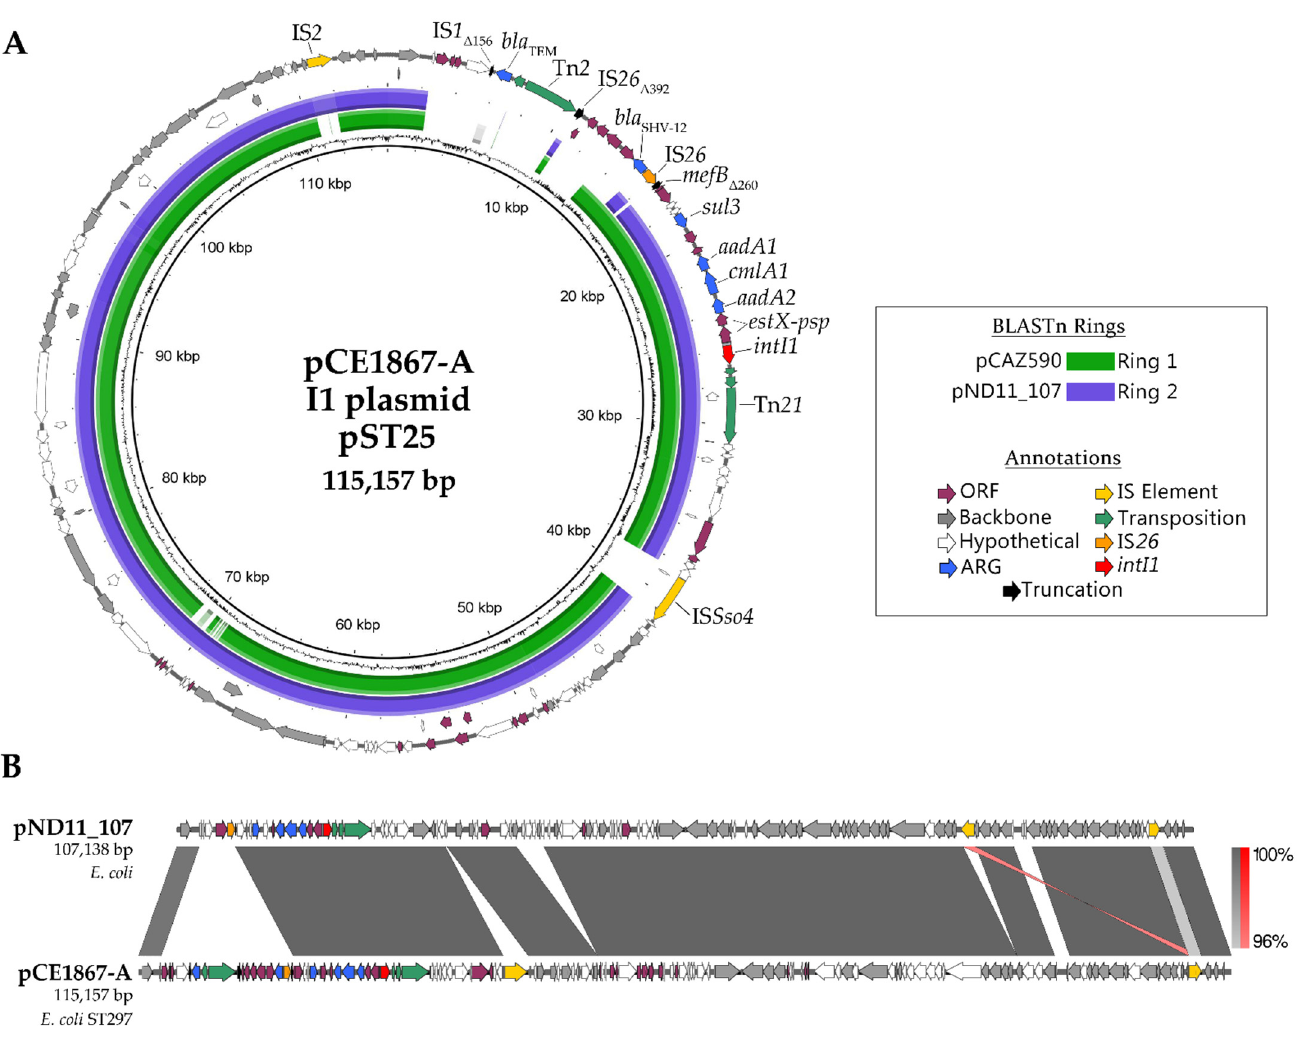
Figure 3. Visualized annotations and BLASTn comparisons between closely related I1 plasmids. ( A ) Circularized and annotated schematic of pCE1867-A with colored rings representing BLASTn alignments to pCAZ590 (green) and pND11_107 (blue). ( B ) Linear comparison of pND11_107 and pCE1867-A annotations, with BLASTn alignments in grey/red between. Table 1. Details of sul3 -encoding I1